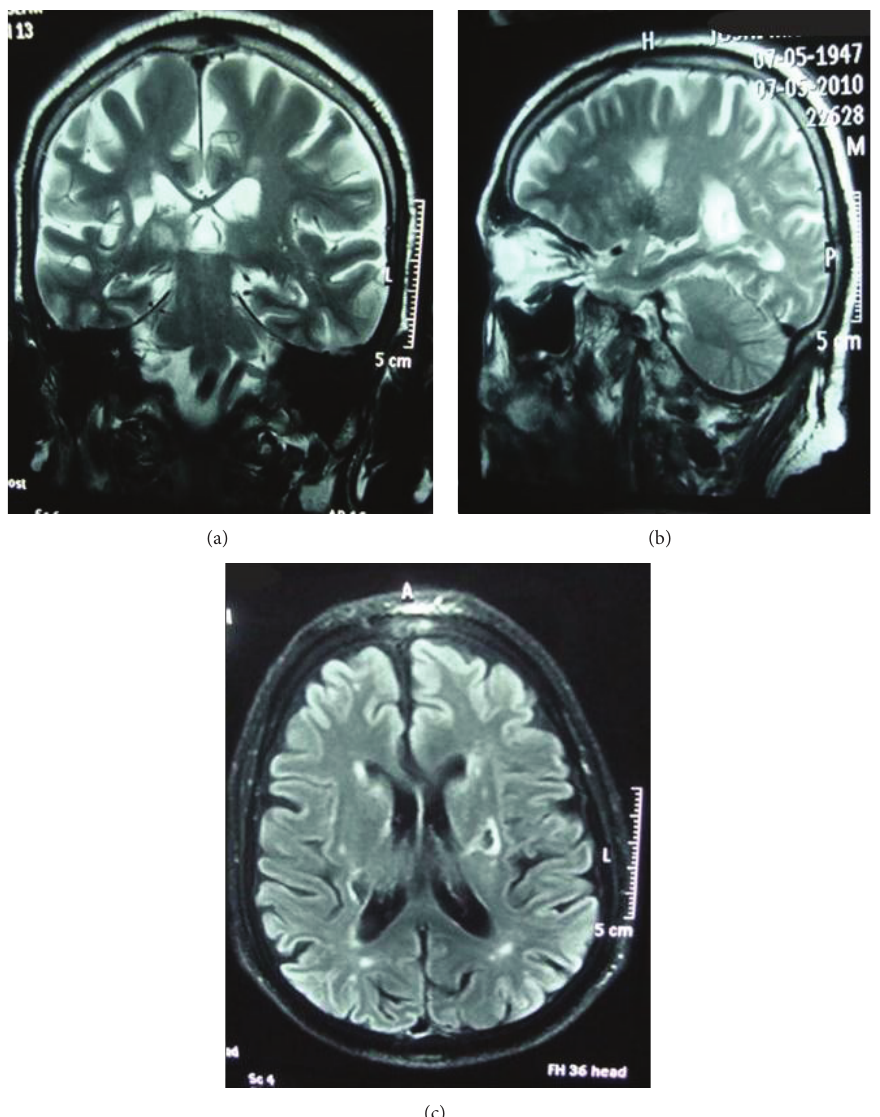
Figure 1: Magnetic resonance imaging of the brain; frontal, sagittal, and transverse sections showing an acute nonhemorrhagic right middle cerebral artery territory infarct with the putamen extending to the corona radiate, 12 hours